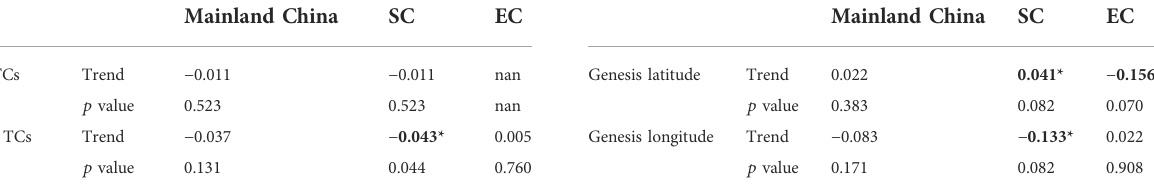
TABLE 4 The same as Table 1, but for the genesis latitude and genesis longitude of TCs over mainland China, SC, and EC from 1980